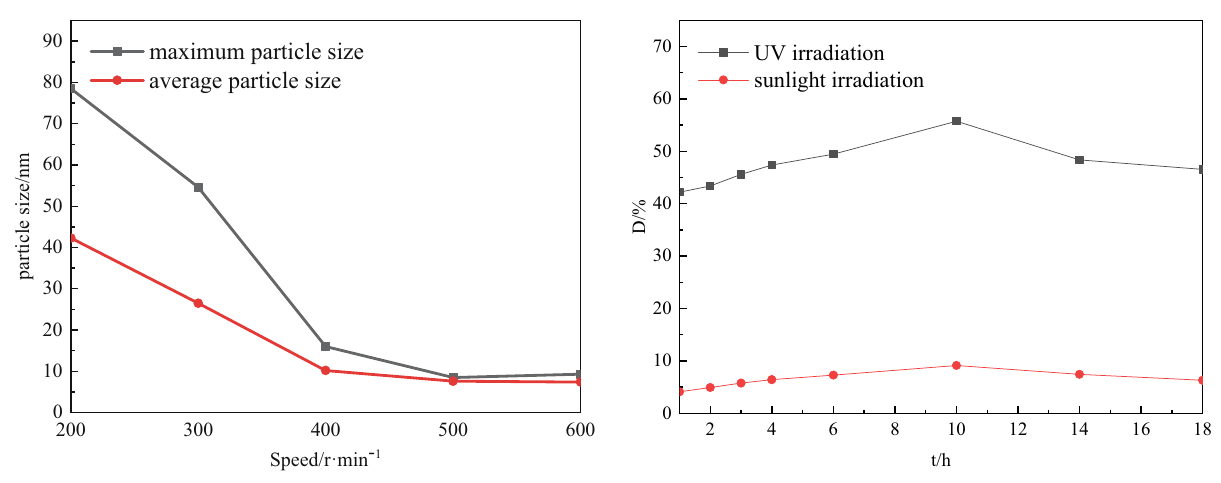
Figure 5: Particle size of CdS/TiO 2 composite photocatalysts at di ff erent ball milling speeds.